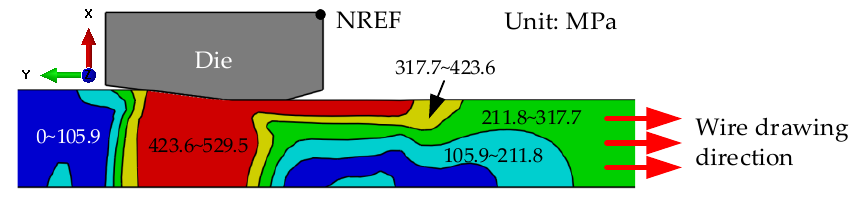
Figure 13. Mises equivalent stress distribution of the wire at the contact region under conventional drawing conditions.